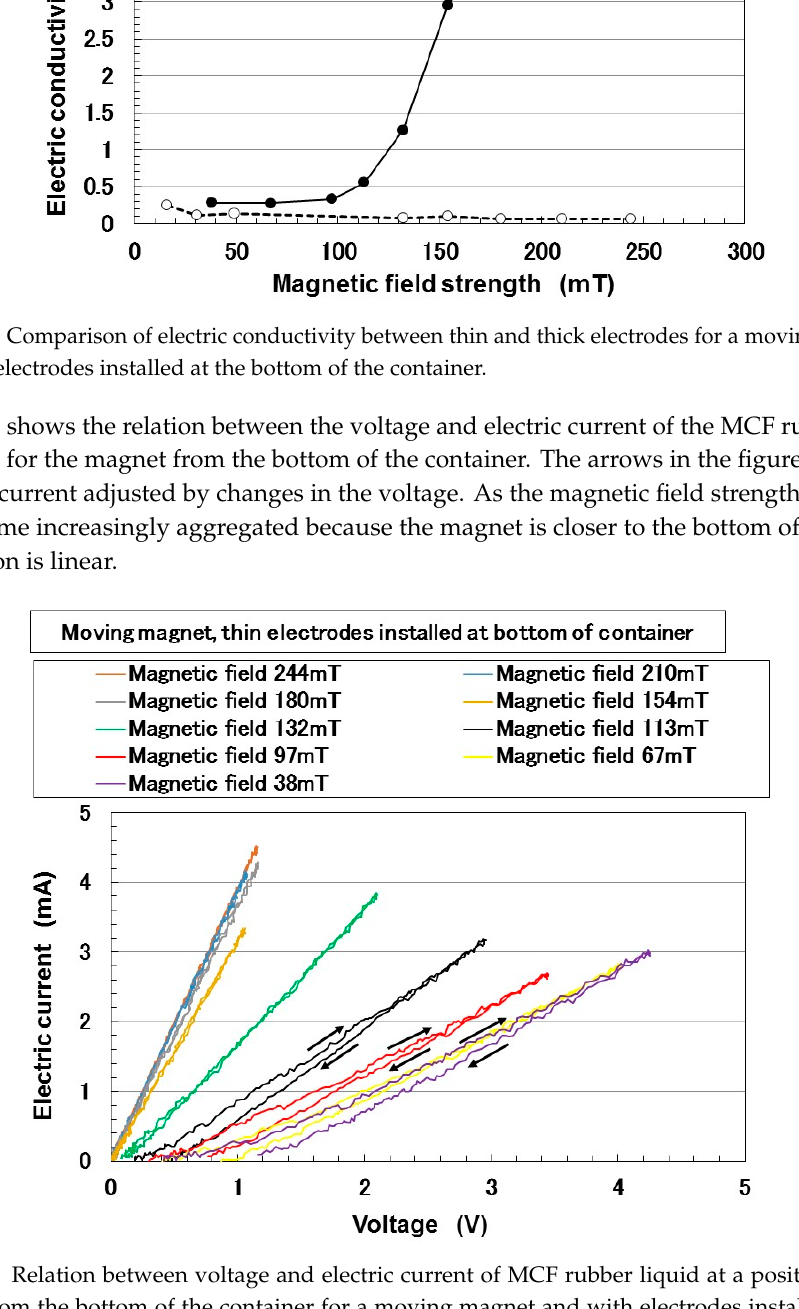
Figure 11. Relation between voltage and electric current of MCF rubber liquid at a position of the magnet from the bottom of the container for a moving magnet and with electrodes installed at the bottom of the container.